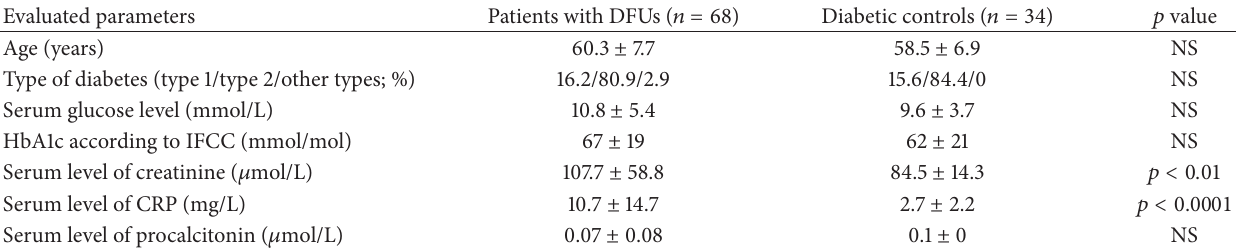
Table 1: A comparison of basic characteristics and certain inflammatory markers between the study groups. Evaluated